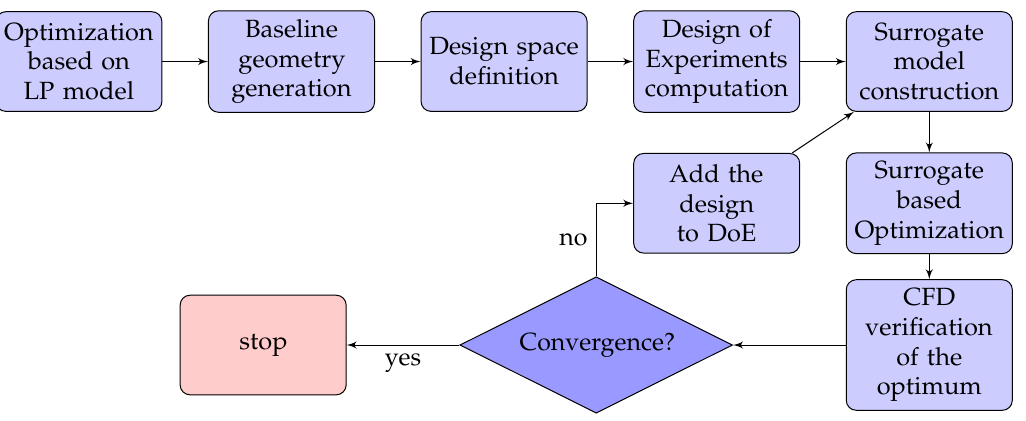
Figure 11. Flow chart of the optimization